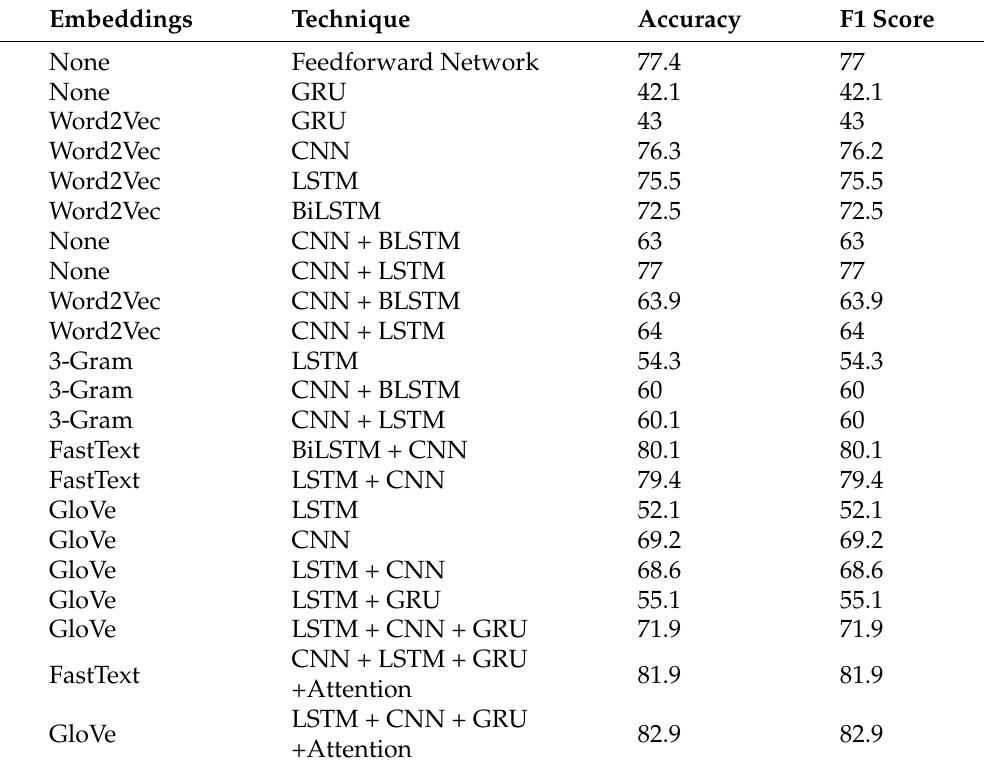
Table 14. Experimental analysis of deep learning models on ternary labeled